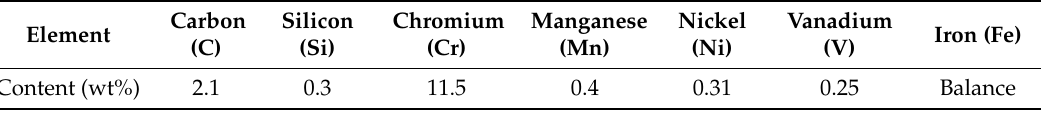
Table 1. Chemical composition in wt% of AISID3 cold work tool